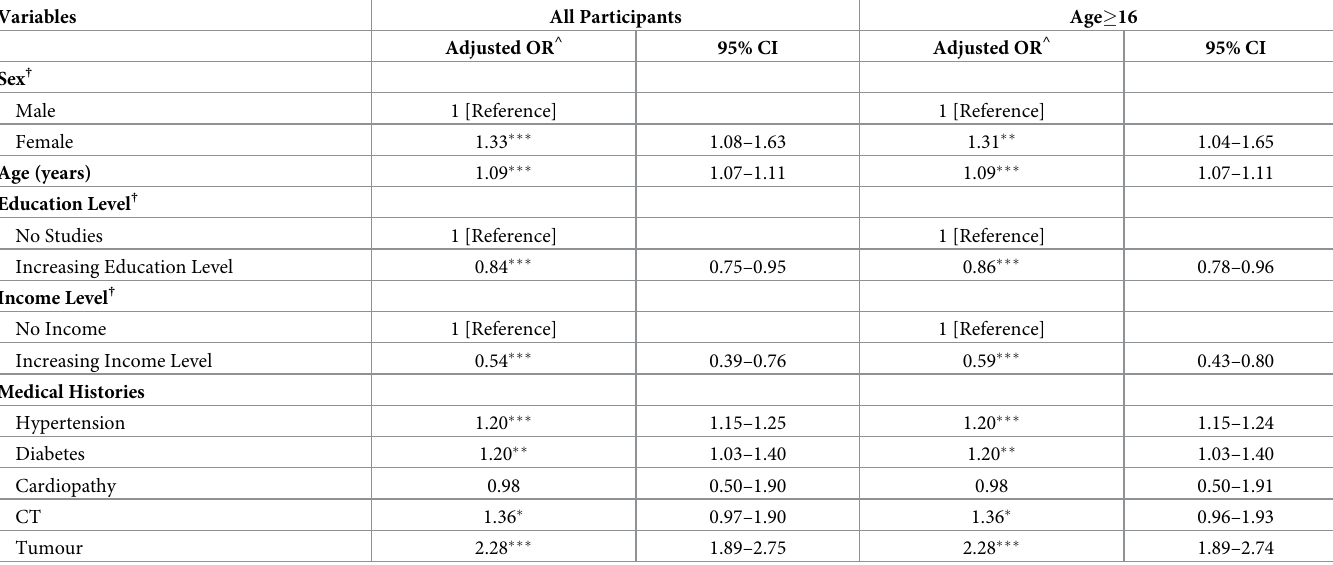
Table 4. Effects of demographic factors, socio-economic status and medical history on visual